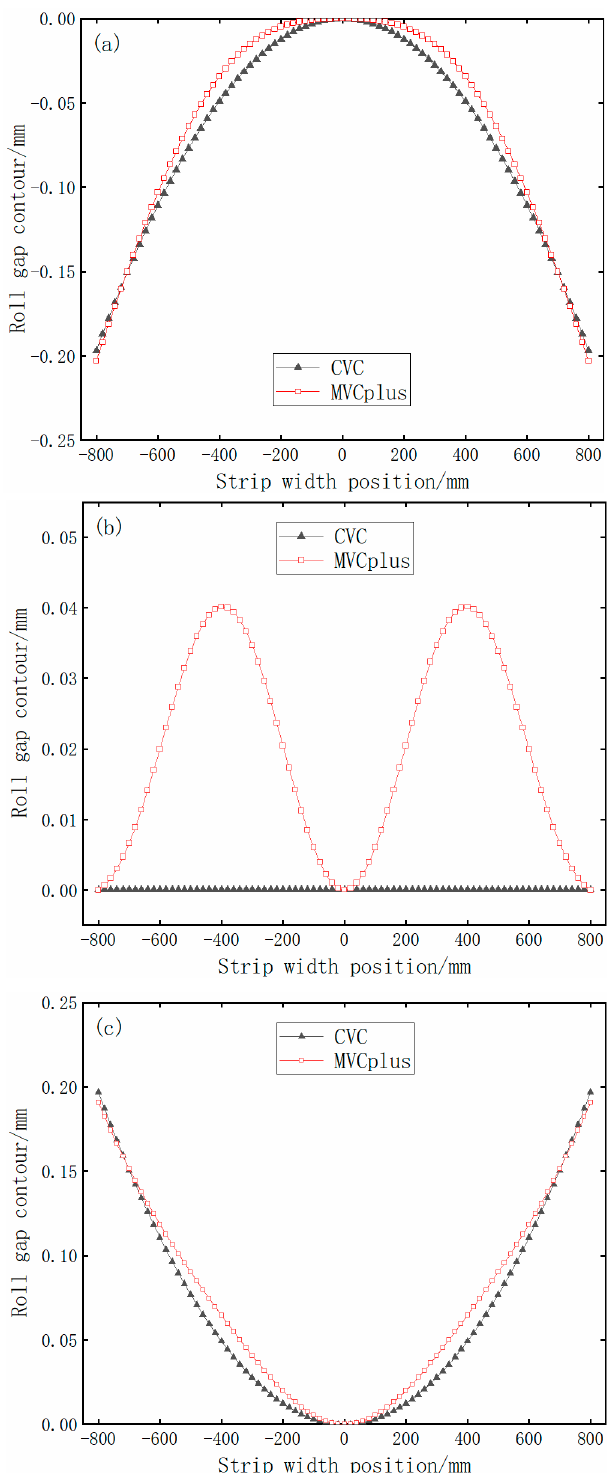
Figure 10. Roll gap contour of MVCplus at different roll shifting positions. ( a ) Roll shifting − 150 mm; ( b ) roll shifting 0 mm; ( c ) roll shifting 150 mm.